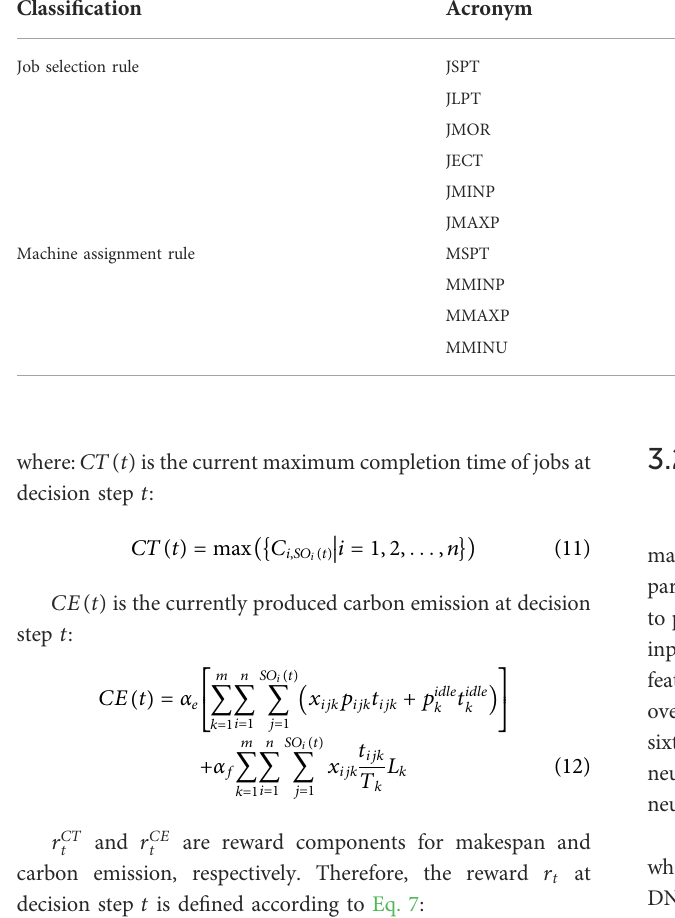
TABLE 3 Job selection and machine assignment